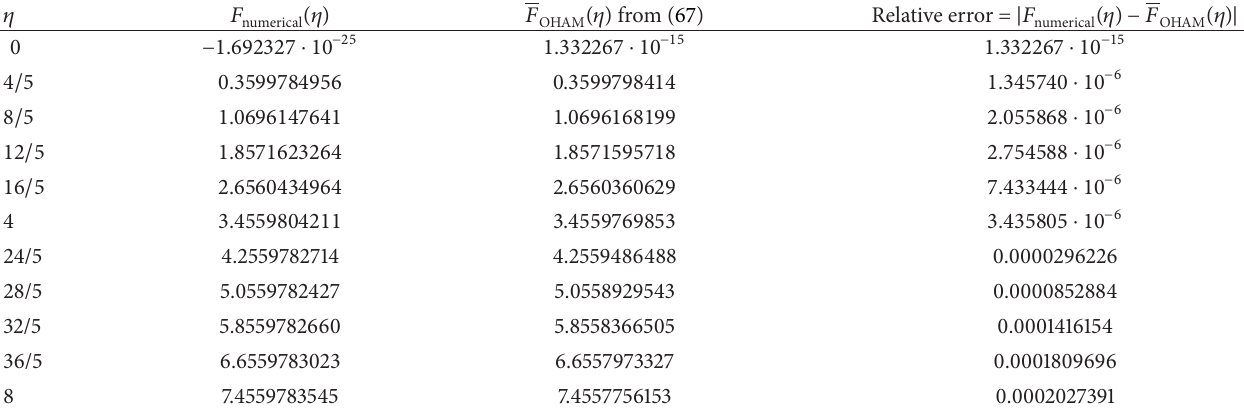
Table 21: Comparison between OHAM results given by (67) and numerical solutions for 𝛽 = 1.6 .